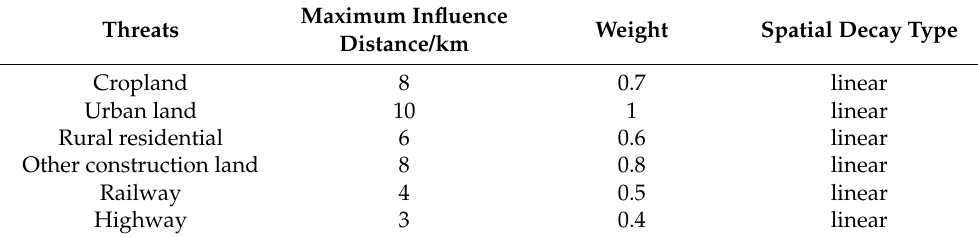
Table 1. Maximum influence distance and weight of the threat factors in TS.